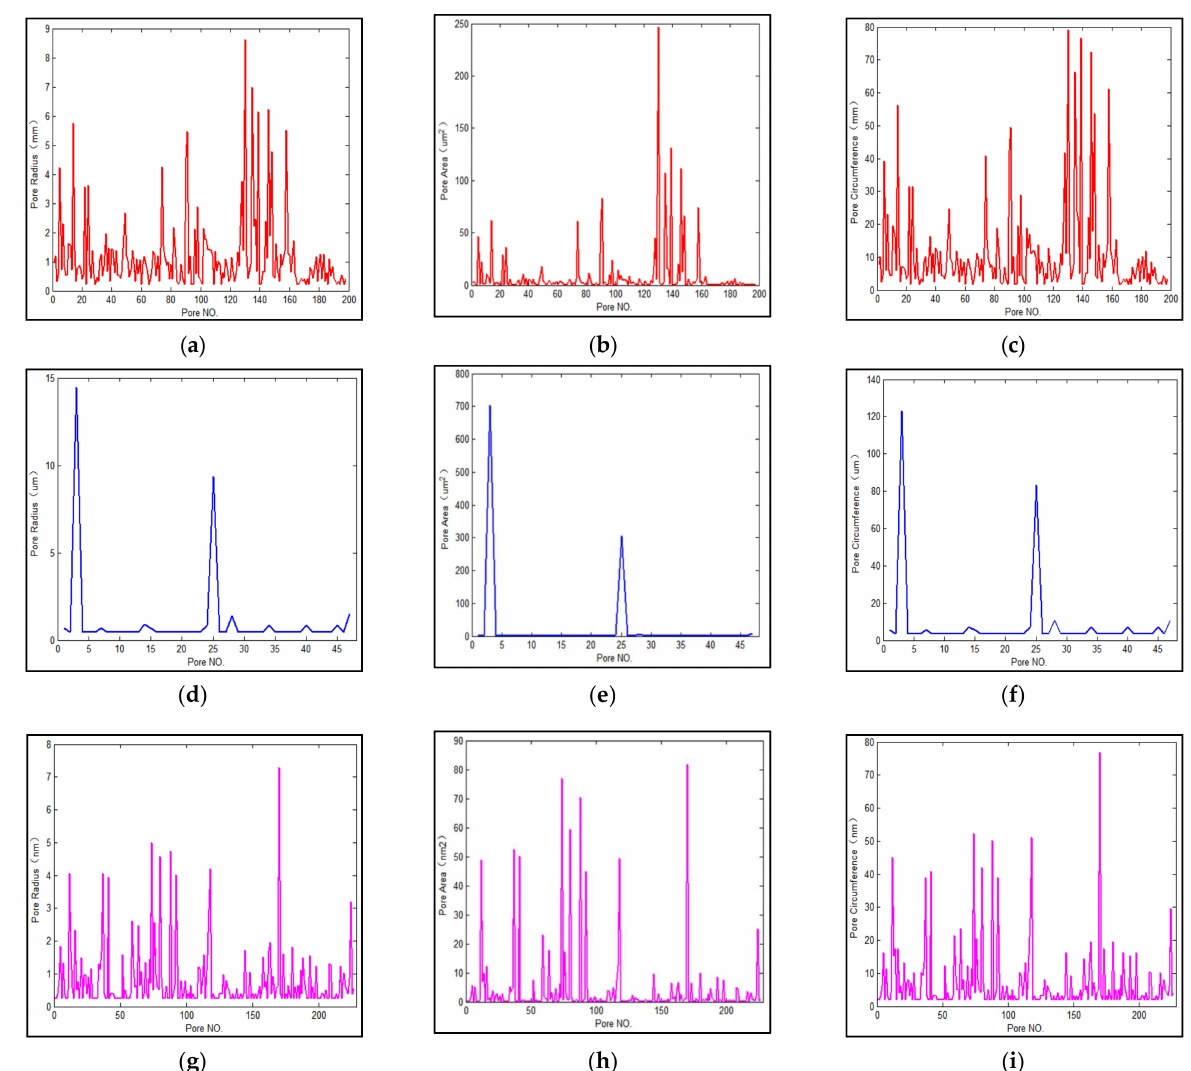
Figure 9. Distribution of multi-scale pore characteristic parameters. ( a ) Macropore radius; ( b ) Macropore area; ( c ) Macropore perimeter; ( d ) Mesoscopic pore radius; ( e ) Mesoscopic pore area; ( f ) Mesoscopic pore perimeter; ( g ) Micropore radius; ( h ) Micropore area; ( i ) Micropore